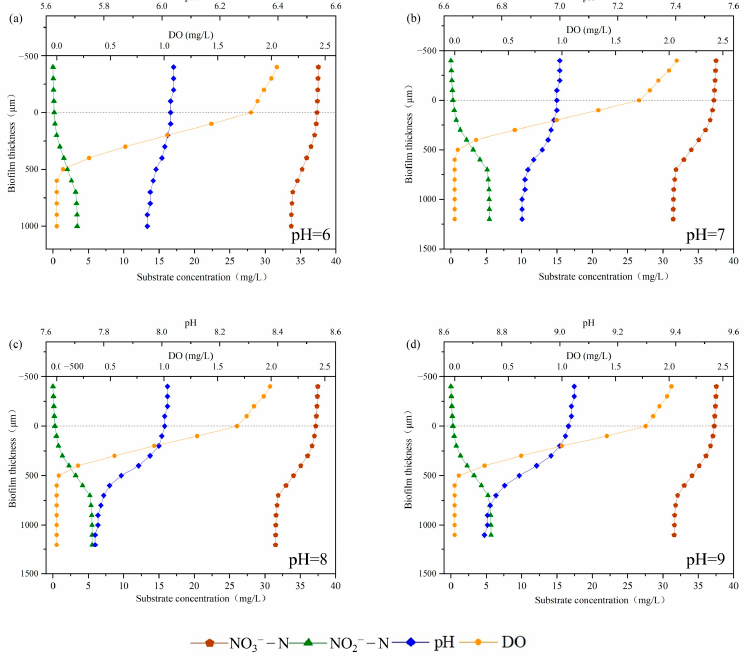
Figure 8. Biofilm thickness and the variation of substrate at different influent pH: ( a ) 6; ( b ) 7; ( c ) 8; ( d ) 9.